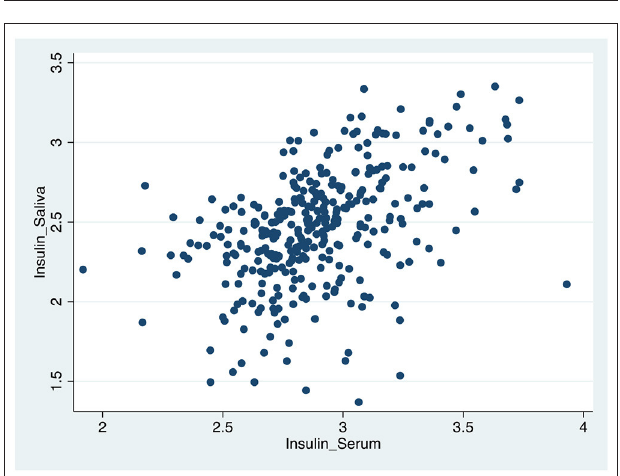
FIGURE 2 | Scatter plot of the correlation between serum and salivary insulin biomarker levels.